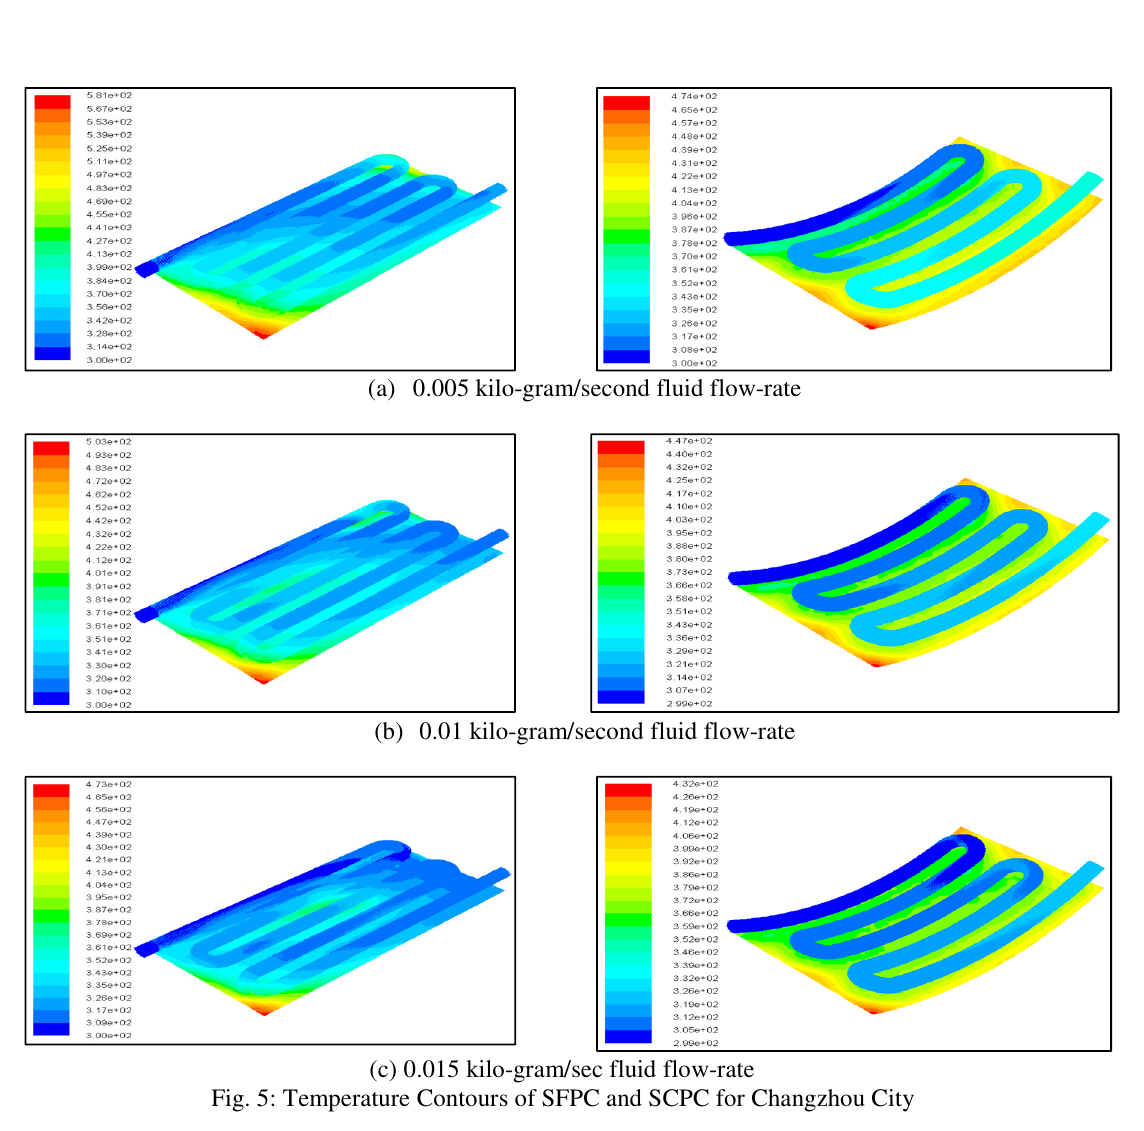
Fig. 5: Temperature Contours of SFPC and SCPC for Changzhou